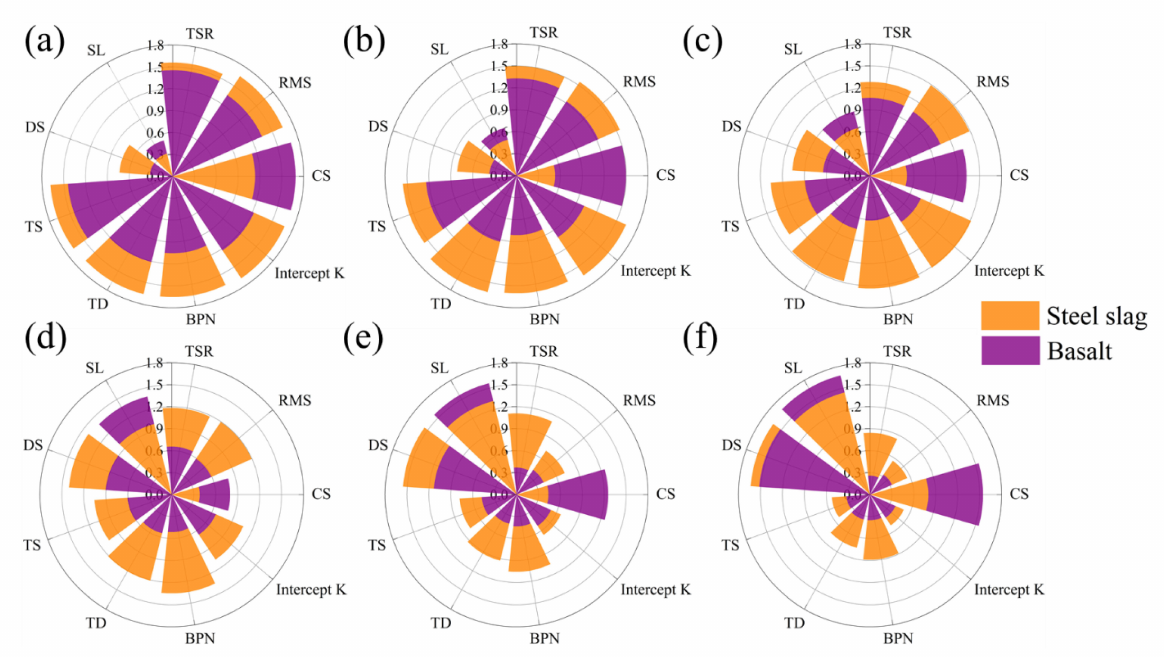
Figure 11. Radar charts for RAM with different RAP content: ( a ) 0 RAP; ( b ) 10% RAP; ( c ) 20% RAP; ( d ) 30% RAP; ( e ) 40% RAP; ( f ) 50%